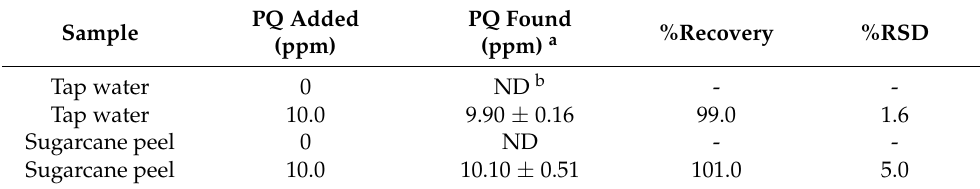
Table 2. Determination of PQ in tap water and sugarcane peel samples.